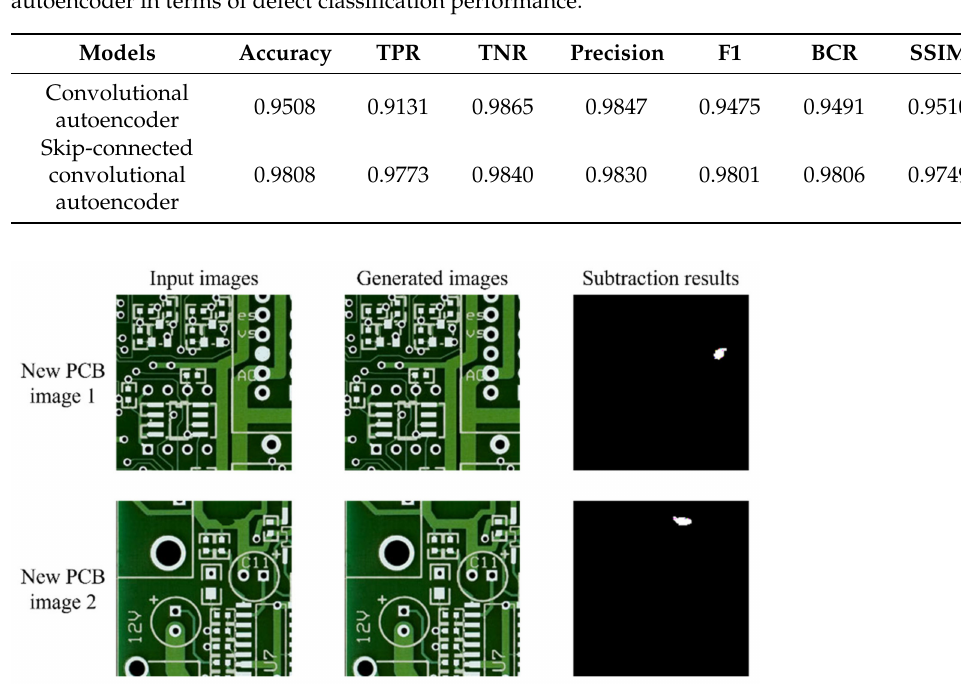
Figure 7. Results from the six test images. The subtraction result is the difference between the generated image and the input image. The binary dilation result is an image whose noise is removed by using the dilation technique. Table 6. Comparison between the convolutional autoencoder and the skip-connected convolutional autoencoder in terms of defect classification performance.